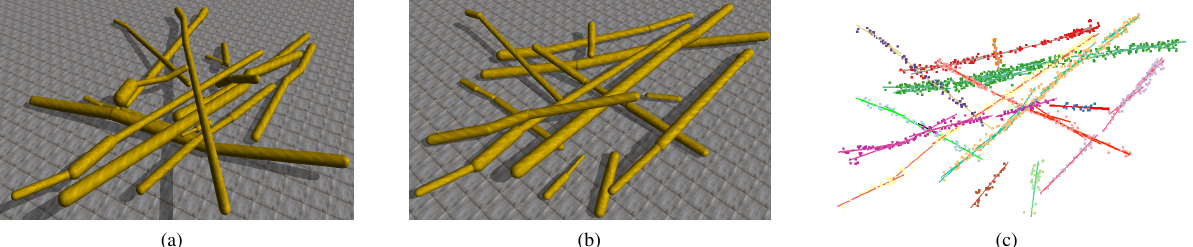
Figure 5: Simulating fallen stems. (a) and (b) depict randomly generated scenarios, (c) shows the ALS points transformed according to the rotations and translations of the stems in scenario (b).